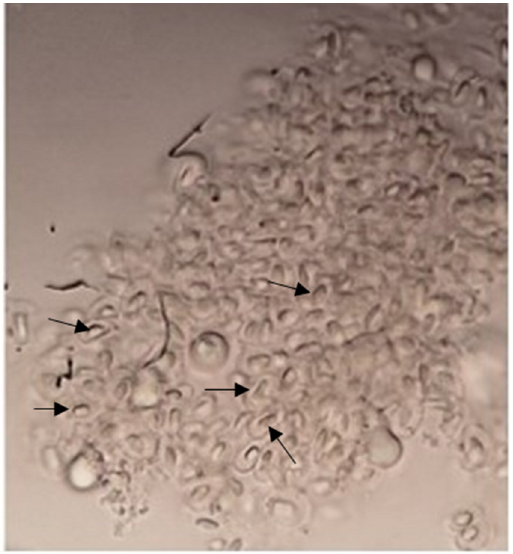
Figure 2. Bacterial count in intestinal samples of fish fed with SPC30Pro, SPC30C, and DCML at the beginning and end of the trial.